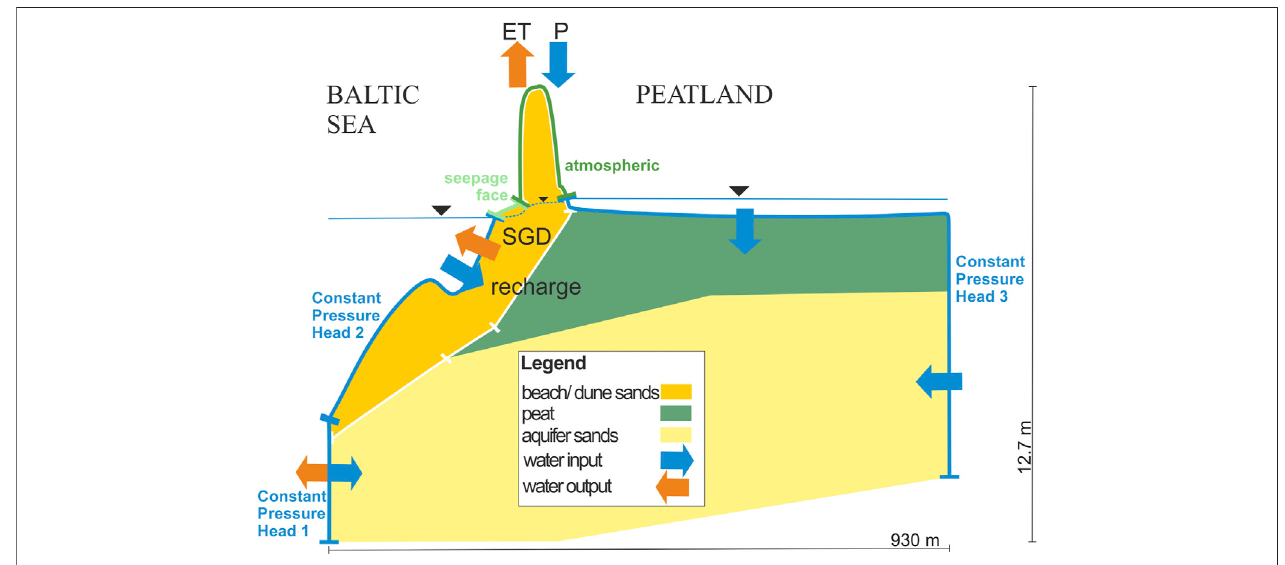
FIGURE 2 | Coastal peatland system with water in- and out fl ows and model boundary conditions. White lines at the boundary of the beach/dune sands are mesh lines used to calculate water fl uxes. The peat extension layer is also depicted here. Note the vertical exaggeration of the cross-section.